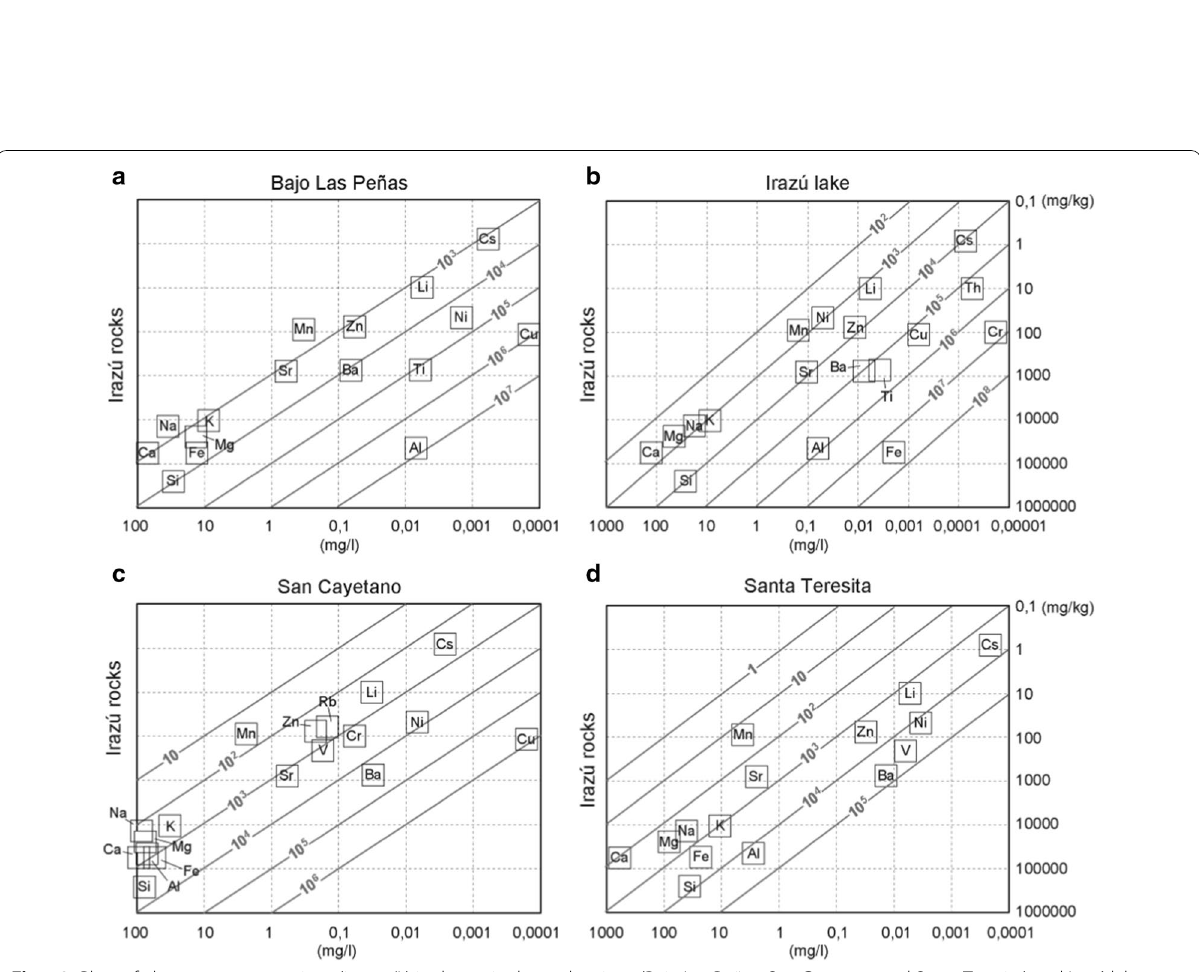
Fig. 10 Plots of element concentrations (in mg/L) in the main thermal springs (Bajo Las Peñas, San Cayetano and Santa Teresita) and Irazú lake vs average element concentrations in Irazú rocks (in mg/kg), which are fully comparable to those of Turrialba rocks. Chemical compositions of Irazú and Turrialba rocks are averaged from published data: Clark et al. (1998), Benjamin et al. (2007) for Irazú rocks (# 30 samples); Reagan and Gill (1989) for Turrialba’s rocks (# 7 samples). Oblique lines indicate water–rock ratios ranging from 1 to 10